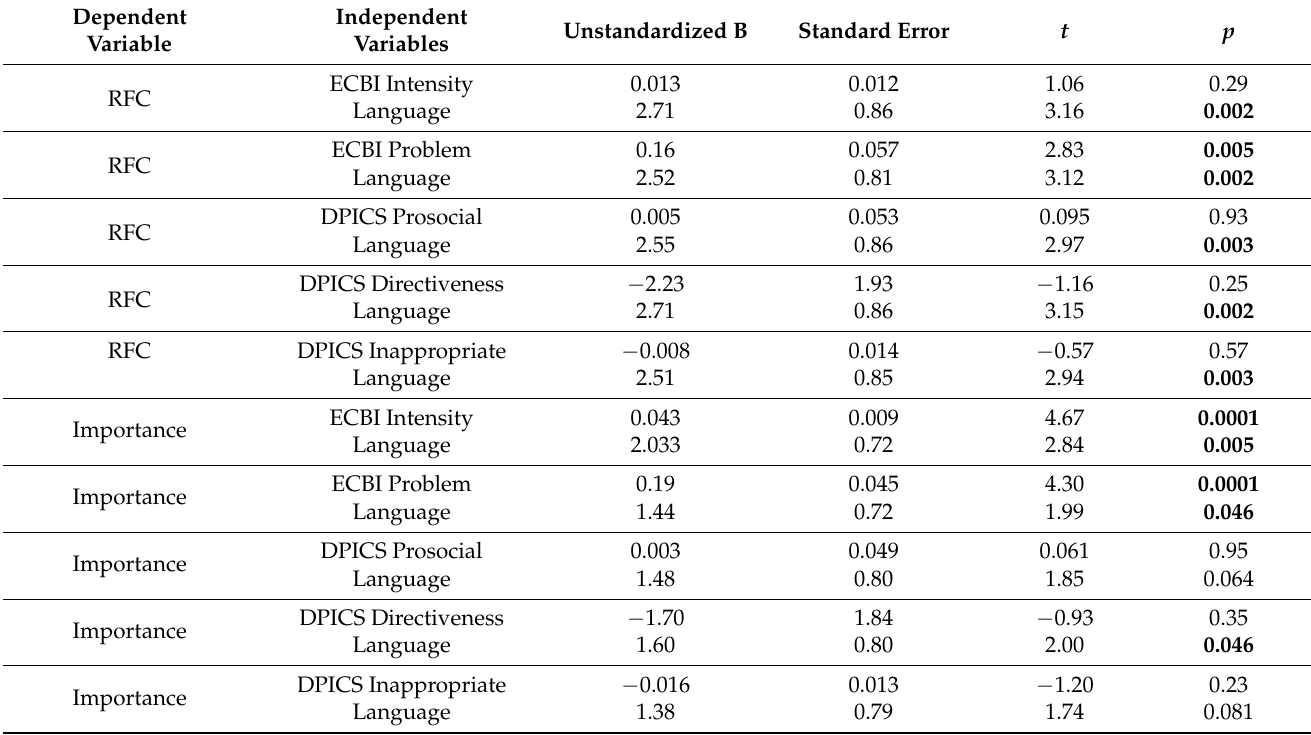
Table 2. Results from Linear Regression Analyses for ECBI Scales and DPICS Codes with Language as Covariate.